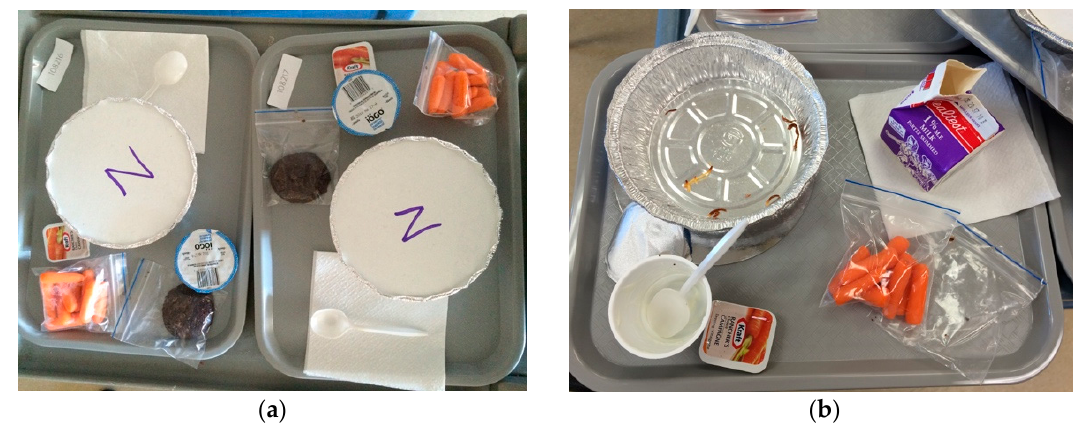
Figure 1. ( a ) Prepared trays served to children in school-based observational feeding study; ( b ) Plate waste collected for weighing after lunch in school-based observational feeding study.